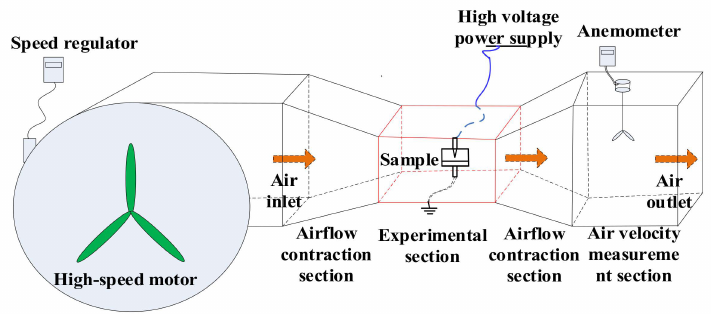
Figure 2. System for testing the discharge of insulating media along the surface in an airflow